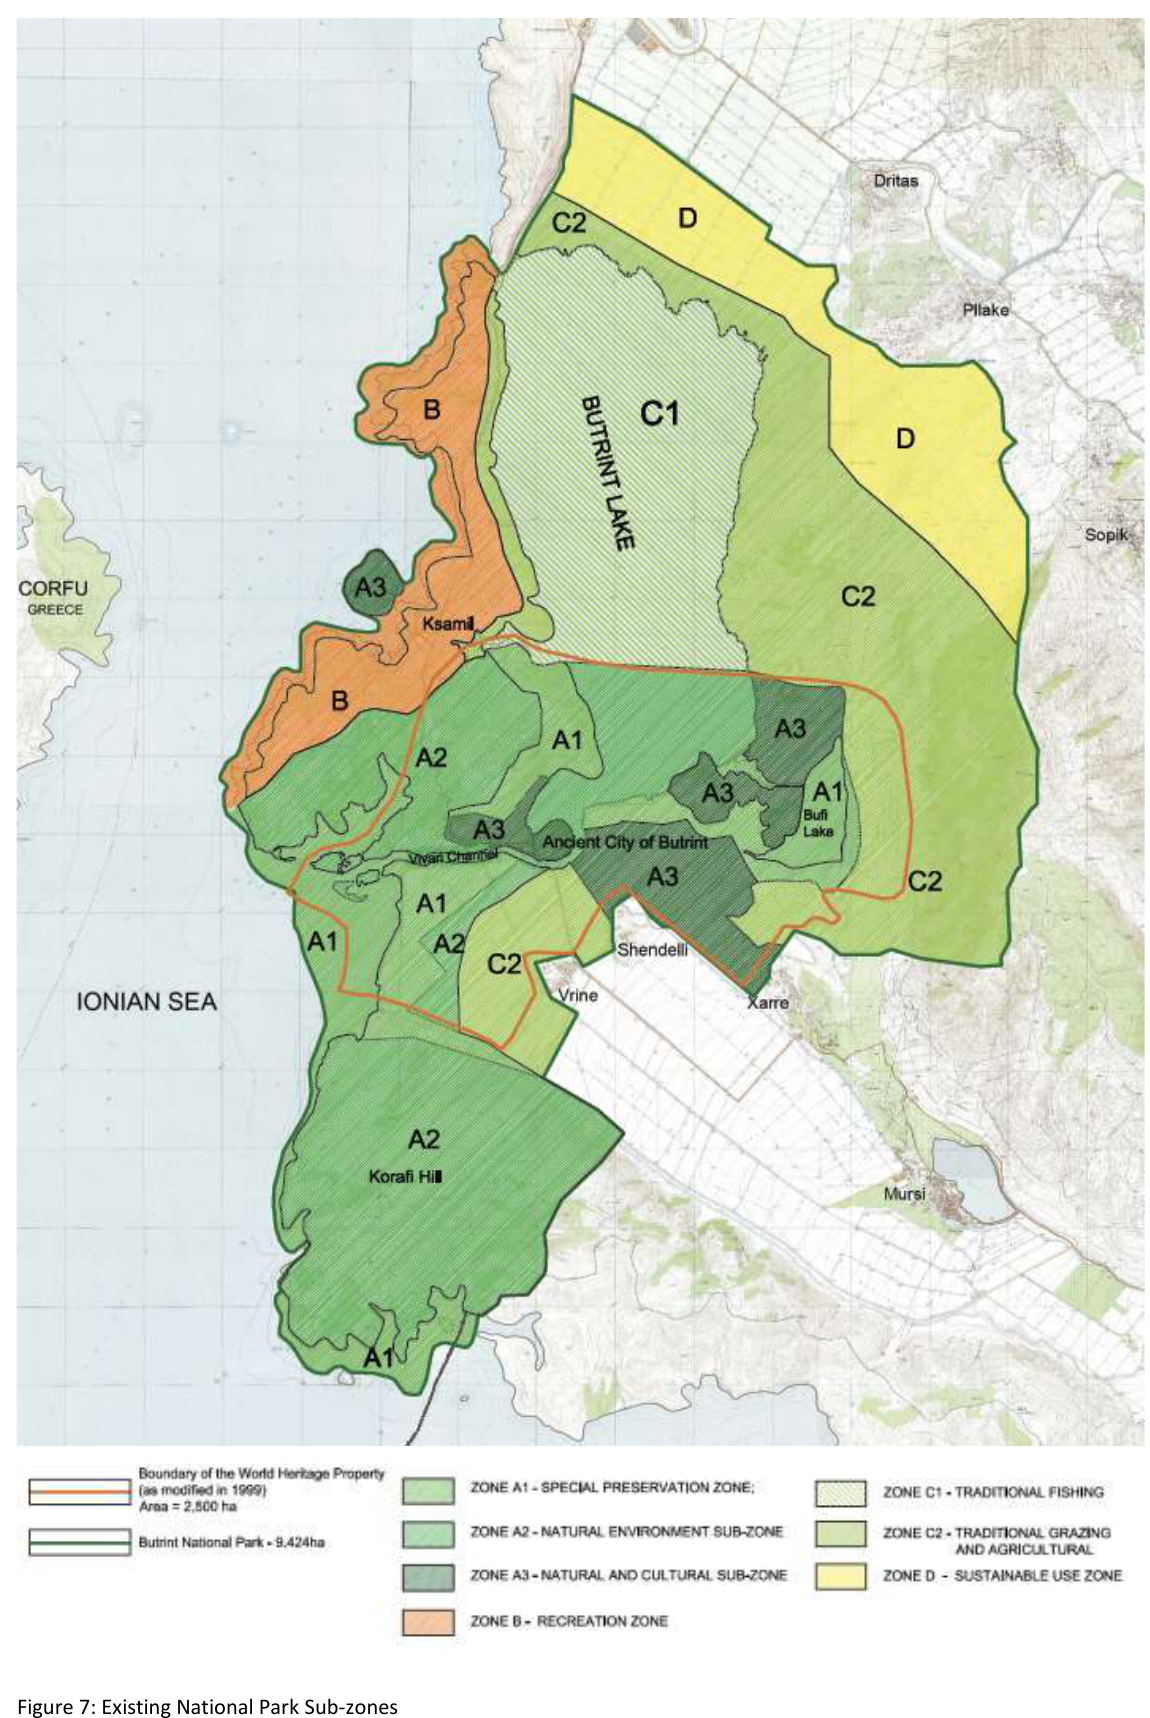
Figure 7: Existing National Park